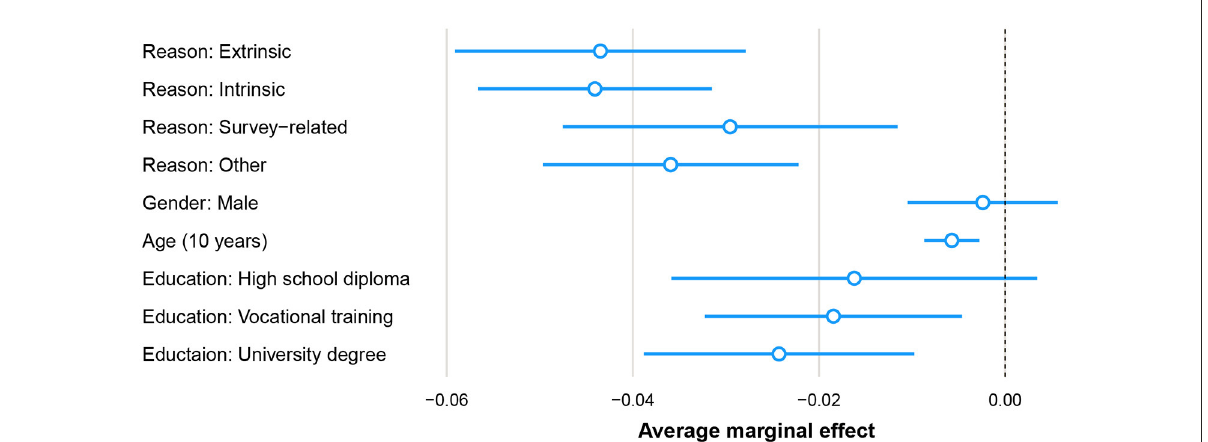
FIGURE3 Logistic regression of panel dropout on independent variable most important participation reason, categorized in four broader categories “Extrinsic reasons,” “Intrinsic reasons,” and “Survey-related reasons,” and “Other reasons.” Reference category for reason: No reason given, reference category for gender: female, reference category for education: no formal education diploma. The AME for unit nonresponse is 0.4140 (SE 0.0183), not depicted since it is outside of the x-axis